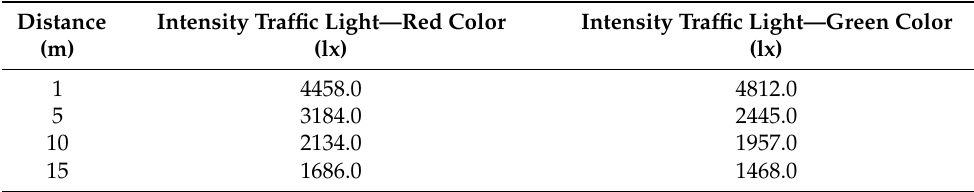
Table 4. Results regarding the analysis, detection of colors, established thresholds, values measured according to distance and confirmation of message